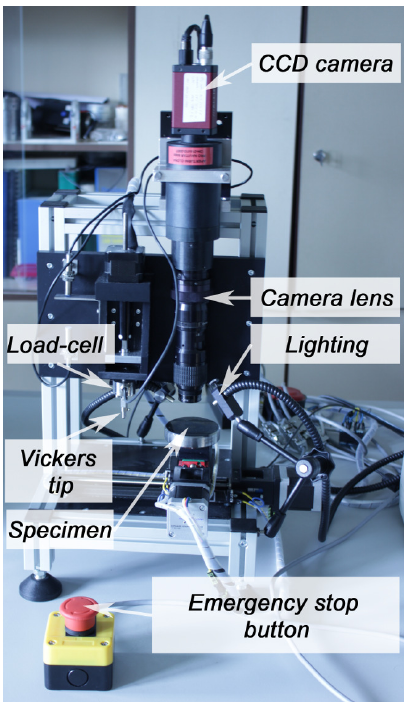
Figure 2. Experimental